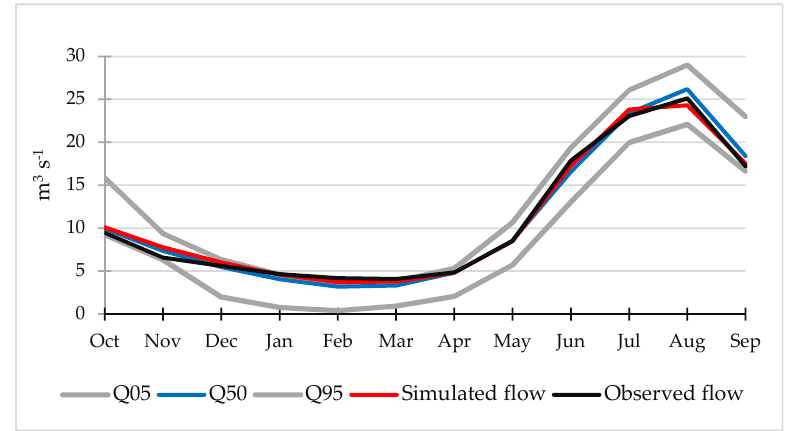
Figure 11. Envelope of simulated values ranging between 5th, 50th, and 95th percentiles containing the observed and simulated mean monthly flow values for the Talgar catchment. Data are averaged over the 2007–2013 period. Validation years are used.